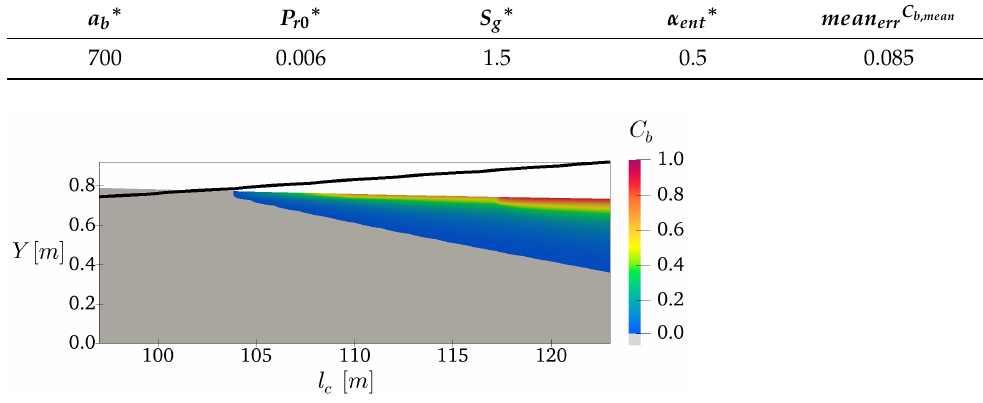
Figure 11. Spillway chute—bubble volumetric concentration. Black line is k = 0.06 m 2 s − 2